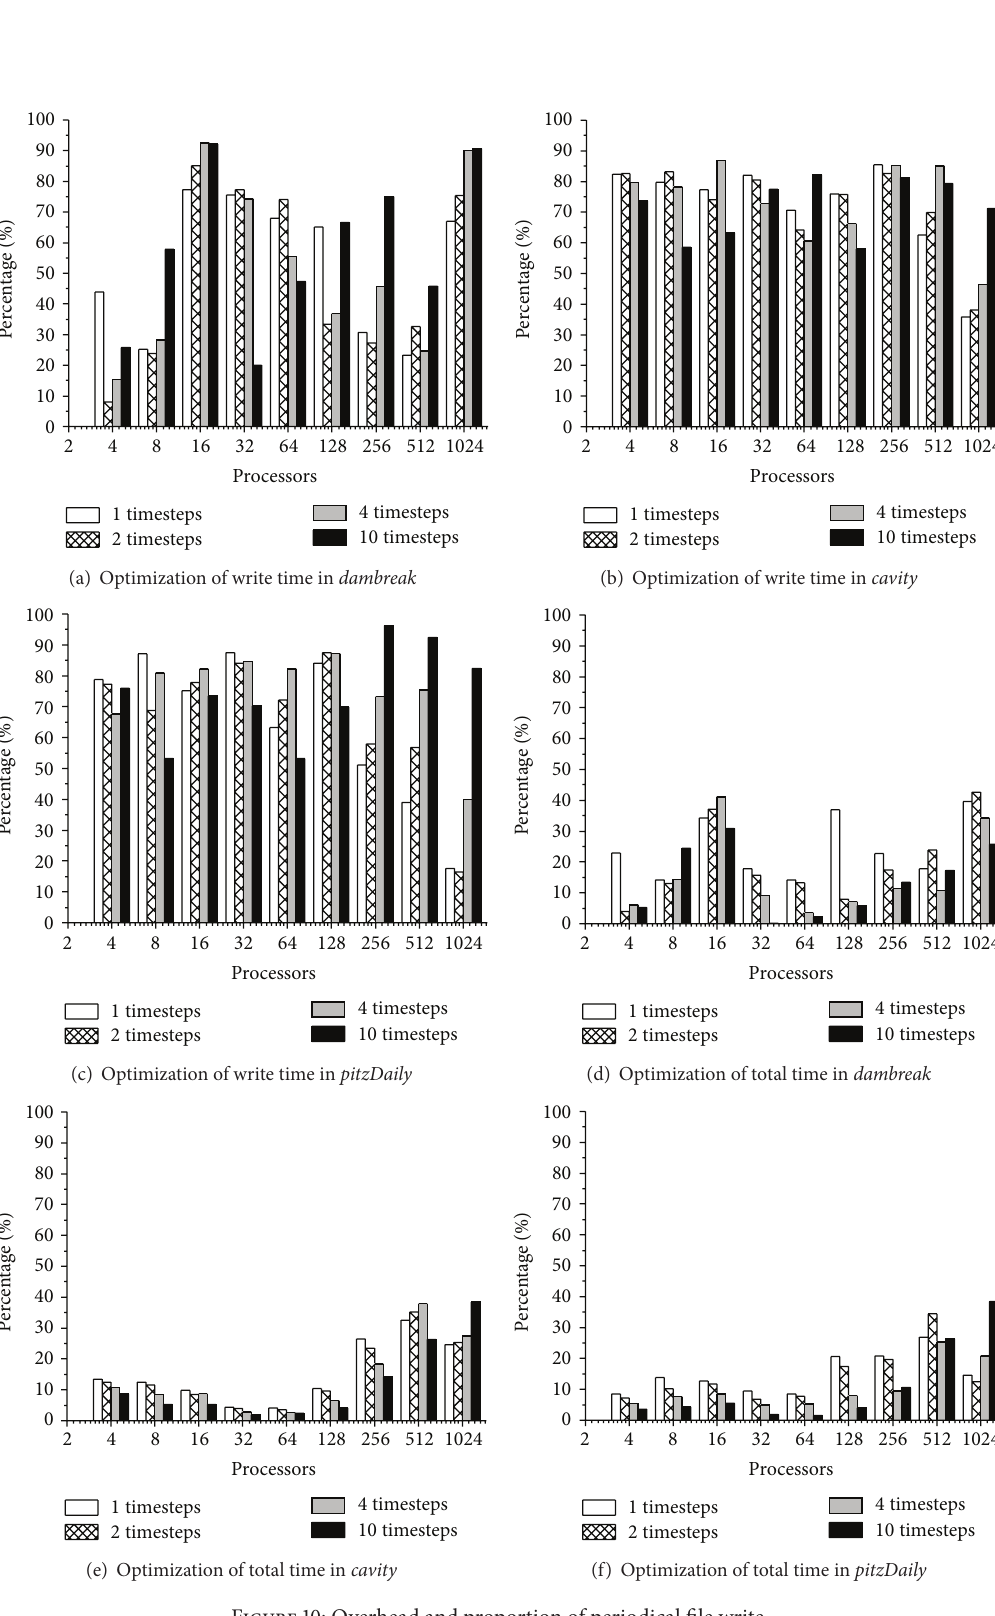
Figure 10: Overhead and proportion of periodical file